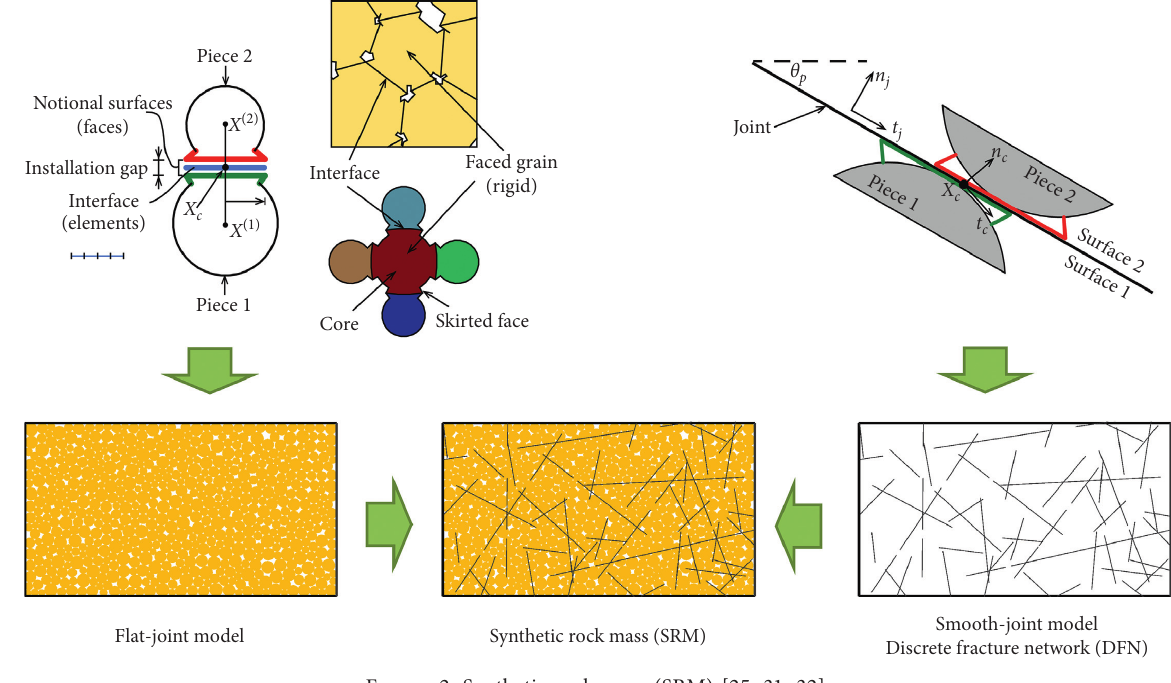
Figure 2: Synthetic rock mass (SRM) [25, 31,